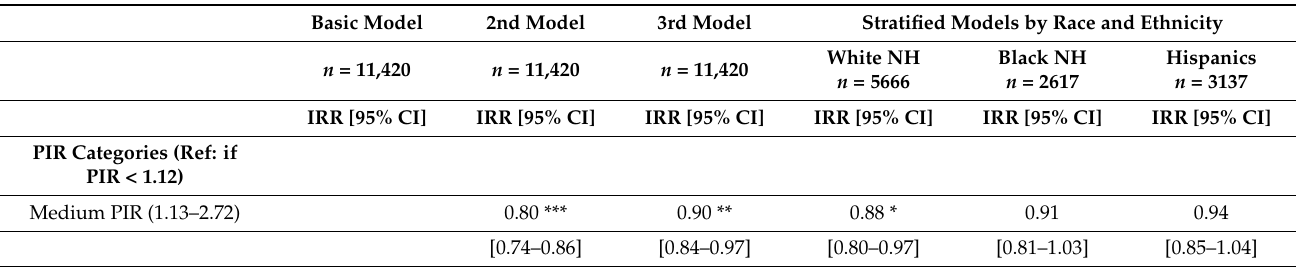
Table 2. Weighted Negative Binomial Regression Estimates in US Women Aged 20 and